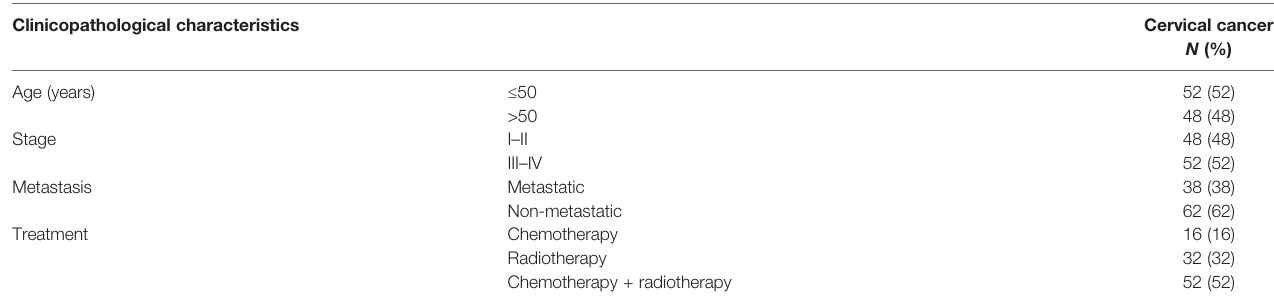
TABLE 2 | Clinicopathological features of the cancer patients enrolled in the study. Clinicopathological